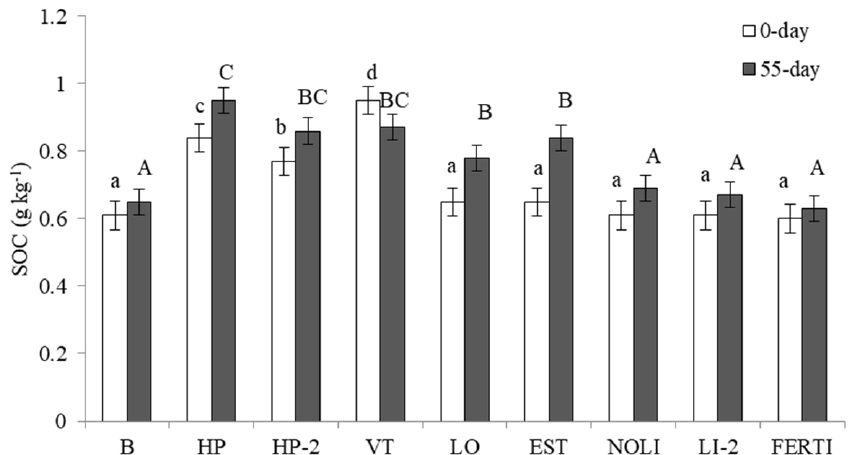
Figure 2. Evolution of soil organic carbon during the experiment. HP: wastewater treatment biosolid + Phoenix dactilifera leaf prunings; HP-2: agrifood sludge from pear processing wastewater + Phoenix dactilifera leaf prunings; VT: vermicompost cow manure; LO: biosolid; EST: cow manure; NOLI: NPK inorganic fertilizer; LI-2: NPK + DMPP inorganic fertilizer; FERTI: fertigation. Different letters within a column indicate significant differences between treatments ( p < 0.05). Bars represent the standard error of the mean.